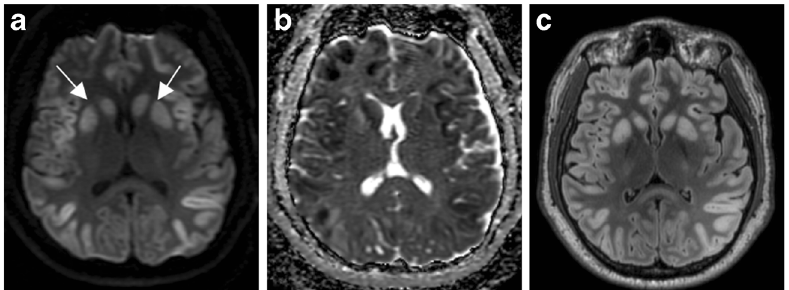
consistent with reduced diffusivity. FLAIR ( c ) illustrates corresponding symmetric increased signal within the basal ganglia and cerebral cortex. All sequences demonstrate notable sparing of the thalami